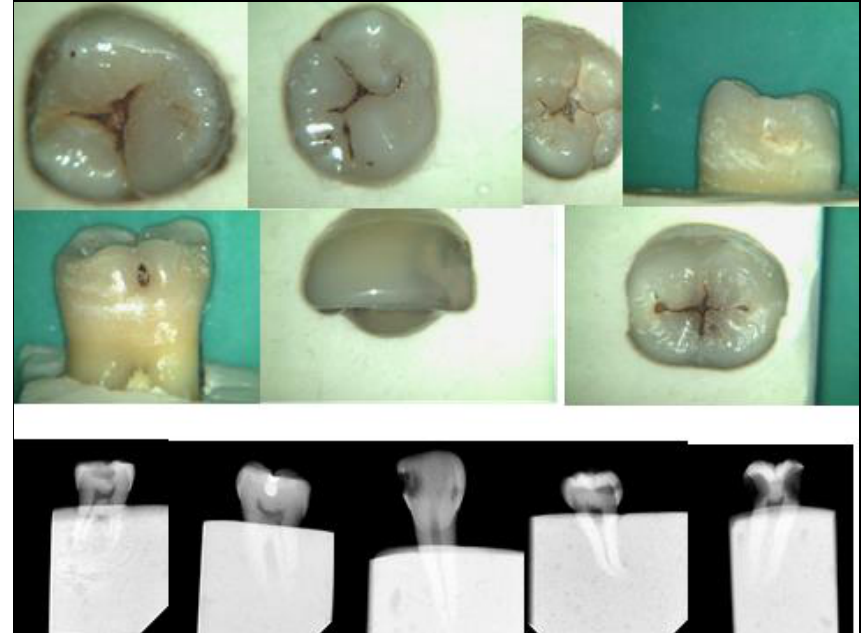
Figure 2. Camsight digital images of extracted teeth depicting different ICDAS codes with some